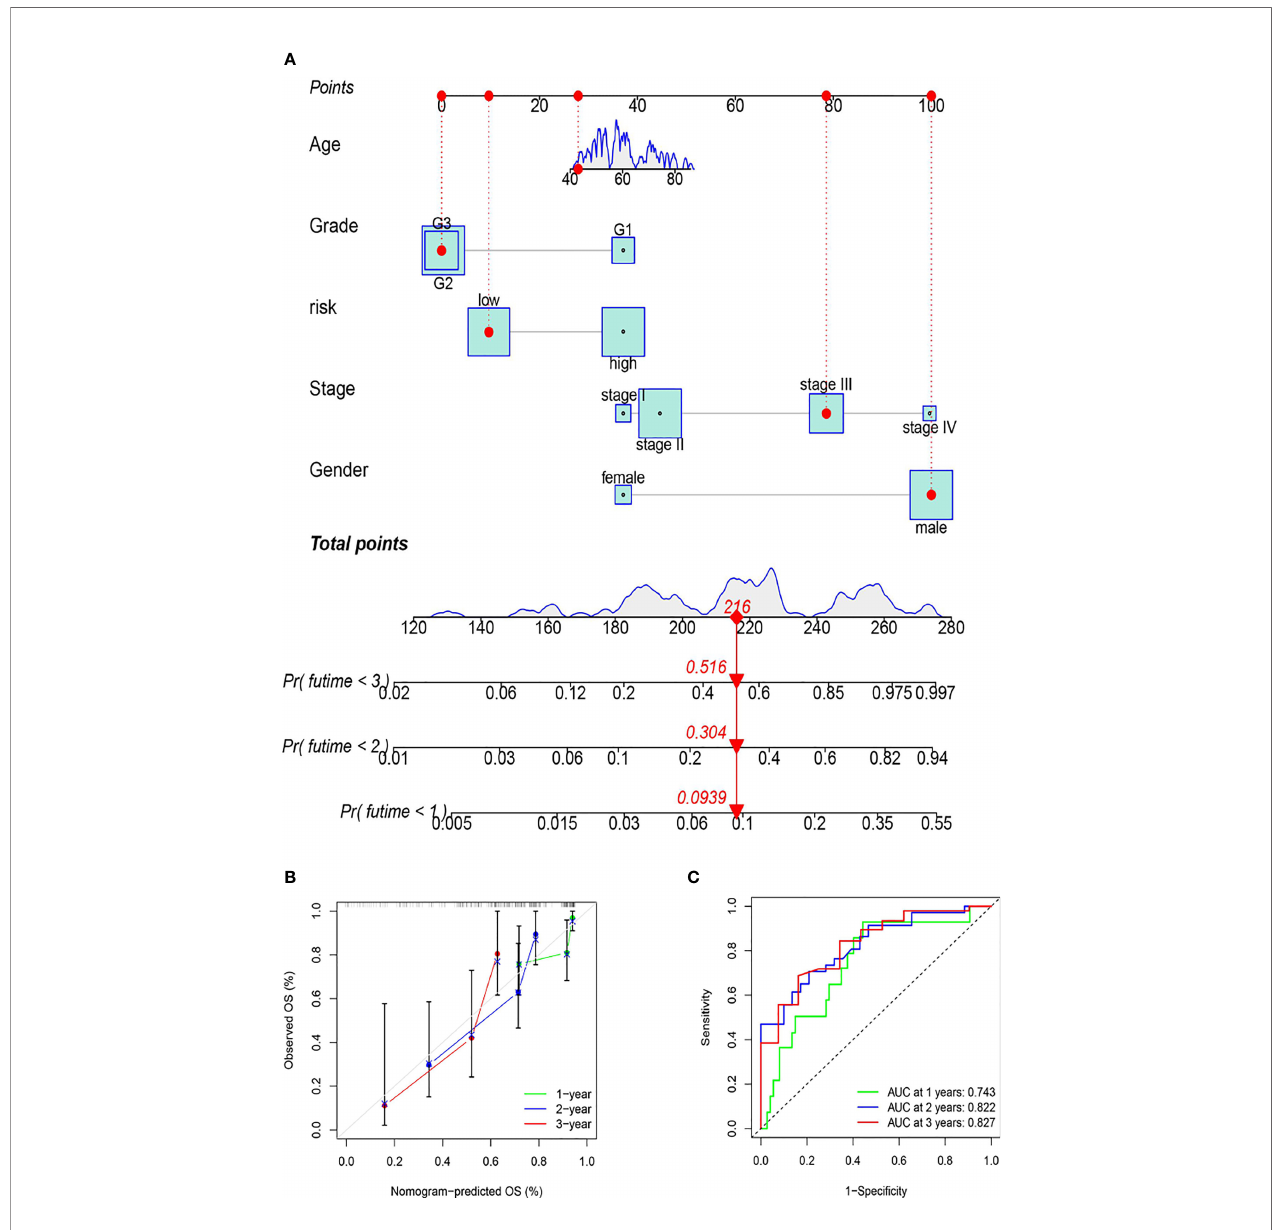
FIGURE 7 | The establishment of the nomogram. (A) Prognostic prediction mechanism of the nomogram (the various elements were scored and summed to produce a total score, and patient survival was predicted based on the total score). (B) The nomogram ’ s accuracy in predicting prognosis was validated by calibration curves. (C) The nomogram ’ s accuracy in predicting prognosis was assessed using ROC curve